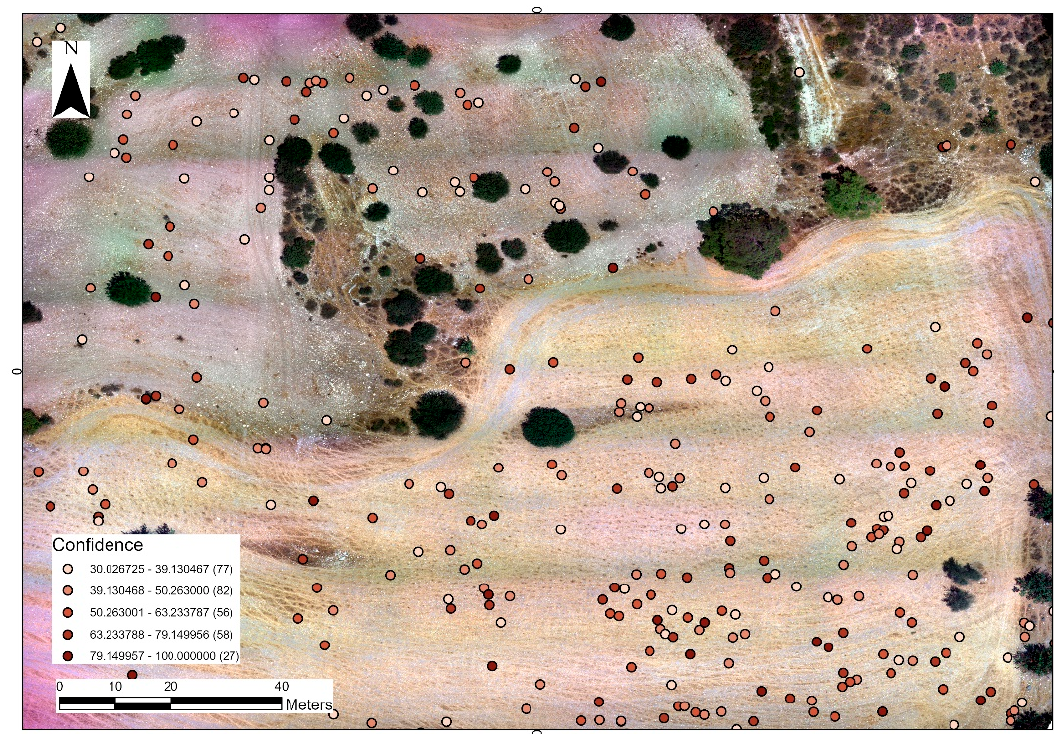
Figure 8. Potsherd detection (points) using the Single Shot deep learning algorithm over Area 6. The various colours indicate confidence level.